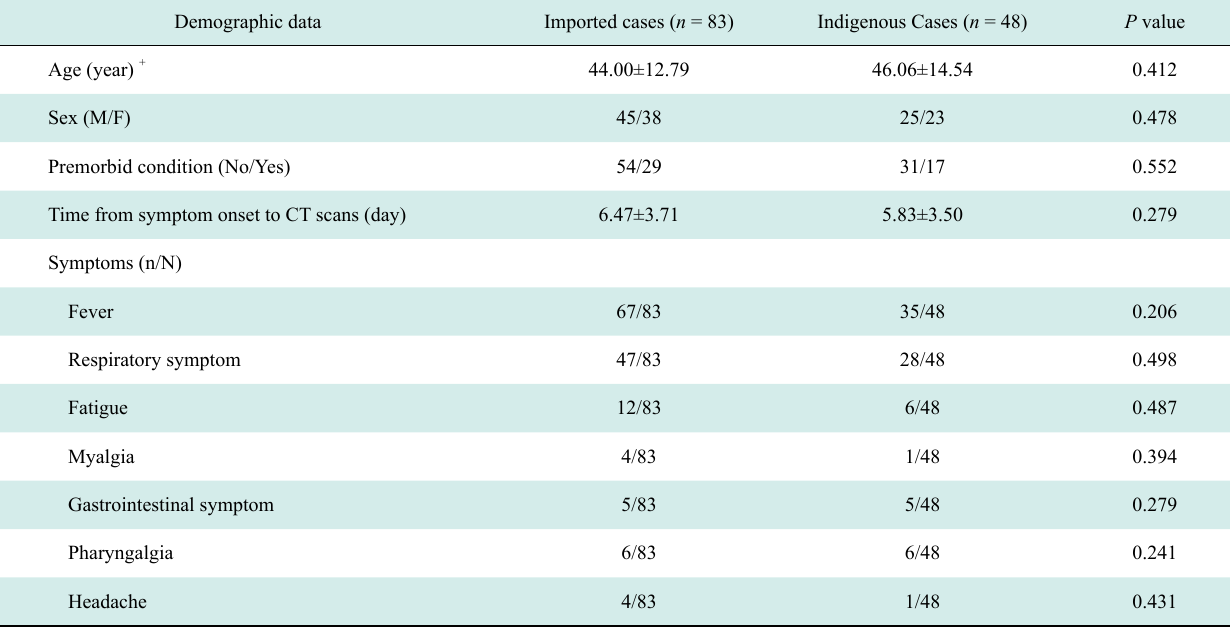
Table 2 Baseline characteristics of patients with COVID-19 between imported and indigenous cases Demographic